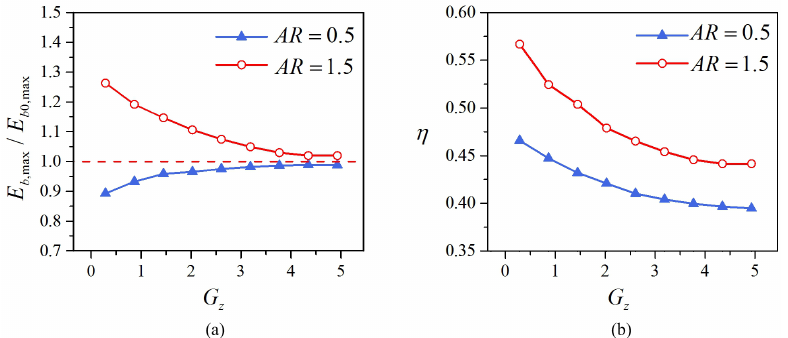
Figure 19. Performance of energy harvesting versus transverse distance: ( a ) bending energy; ( b ) efficiency of bending energy